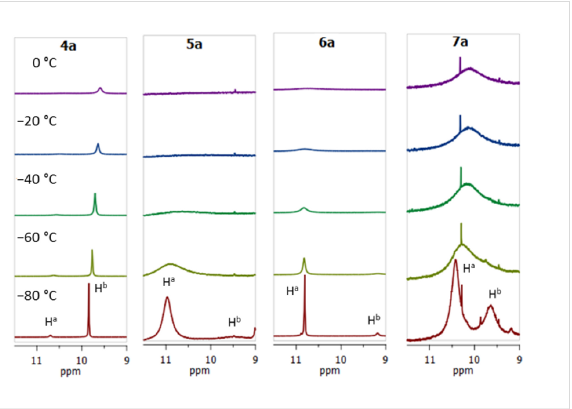
Figure 1: C=NH Signal regions of temperature-depending 1 H NMR spectra for compounds 4a – 7a , acetone- d 6 .